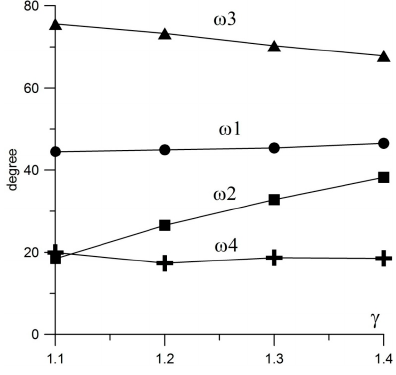
Figure 6. Dependence of the angles with flow direction on γ , α ρ = 0.5 [5].